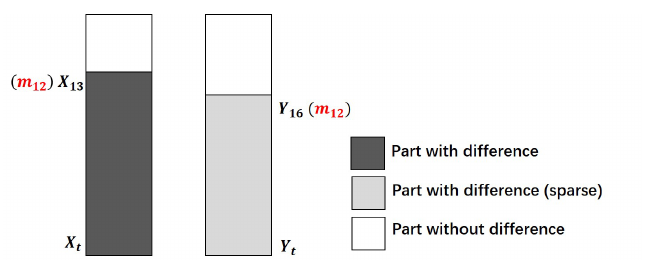
Figure 1: Attack on t steps of RIPEMD-160 by inserting difference at m 12